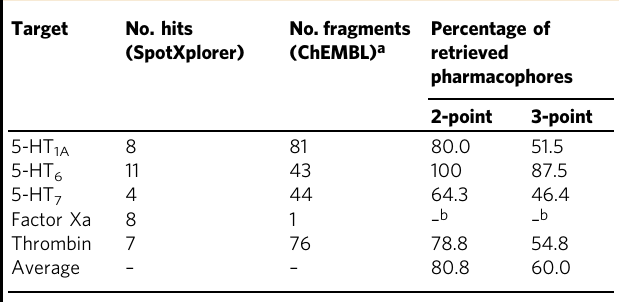
Table 1 Summary of fragment hits from the SpotXplorer0 pilot library and the ChEMBL